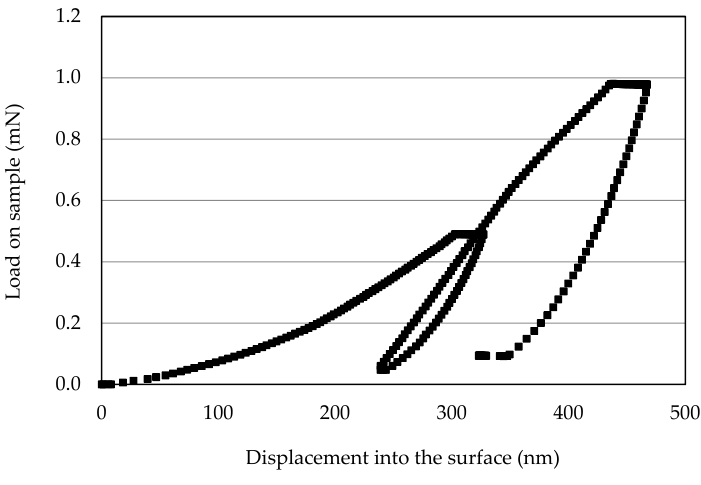
Figure 3. Typical load–displacement curve.